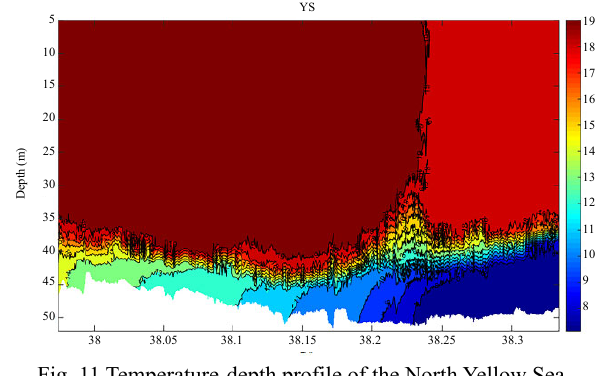
Fig. 11 Temperature-depth profile of the North Yellow Sea.